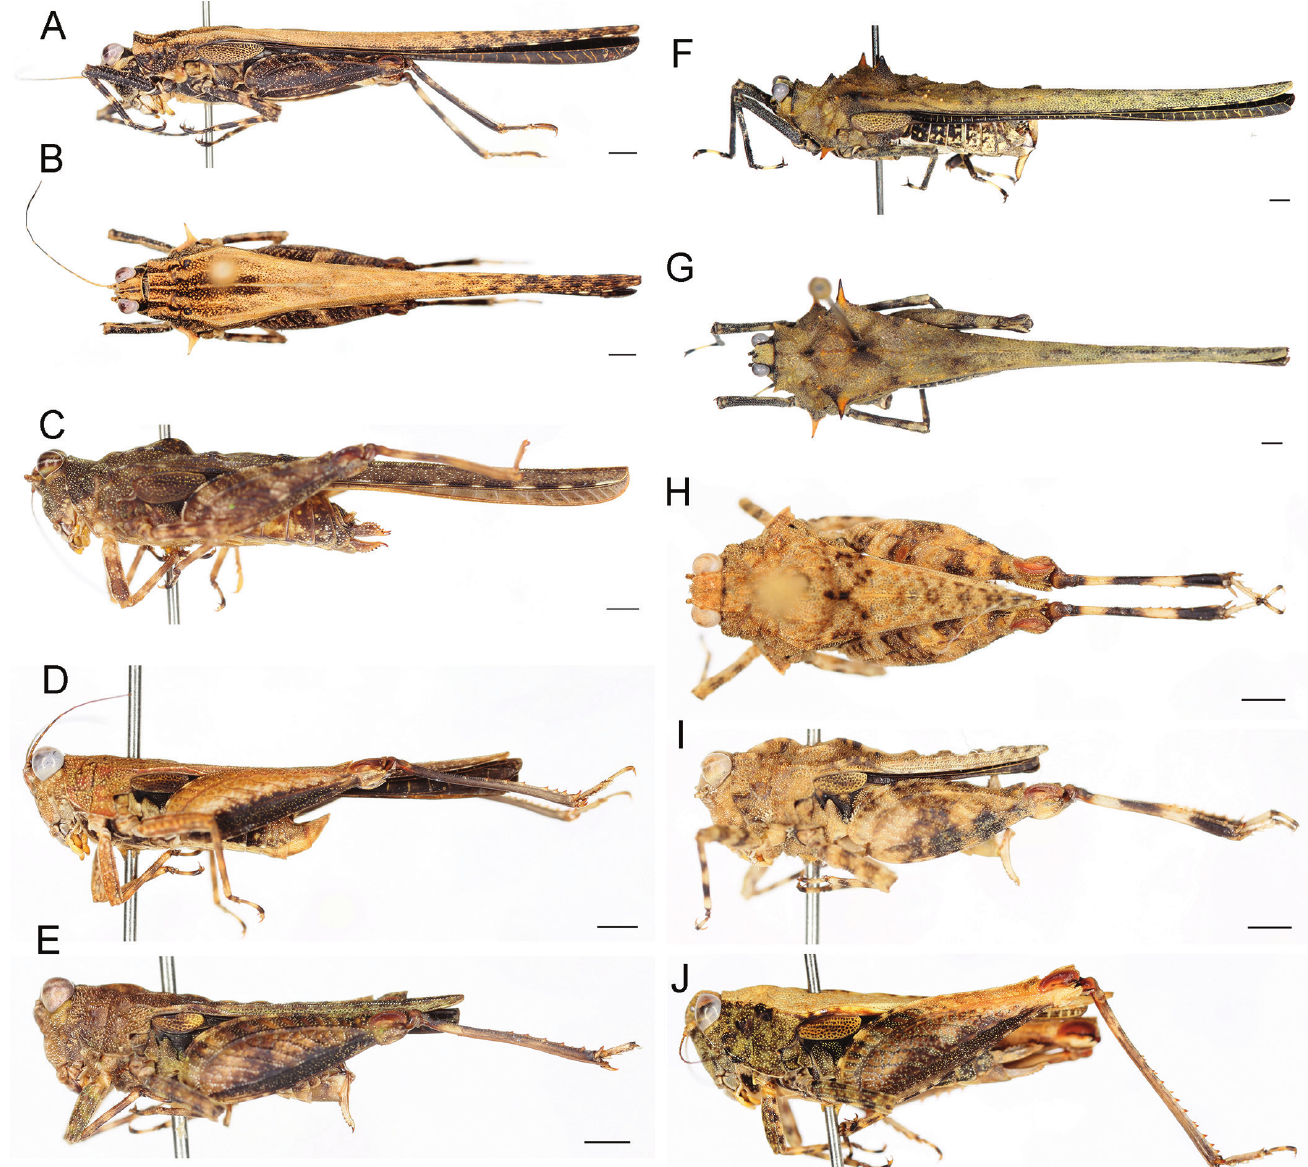
Fig. 6. Tetrigidae: A, B. Falconius clavatus ; C. Falconius deceptor ; D. Loxilobus sp. 1; E. Loxilobus sp. 2; F, G. Scelimena nr. dentiumeris ; H, I. Thoradonta nodulosa ; J. Coptotettix sp. Scale bars: 1